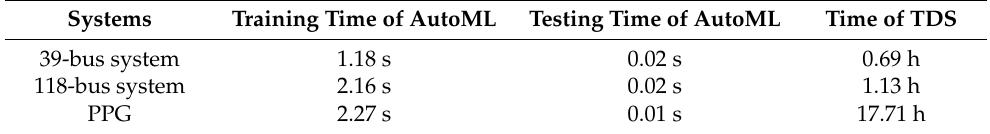
Table 4. Solution time on the three power systems. Systems Training Time of AutoML Testing Time of